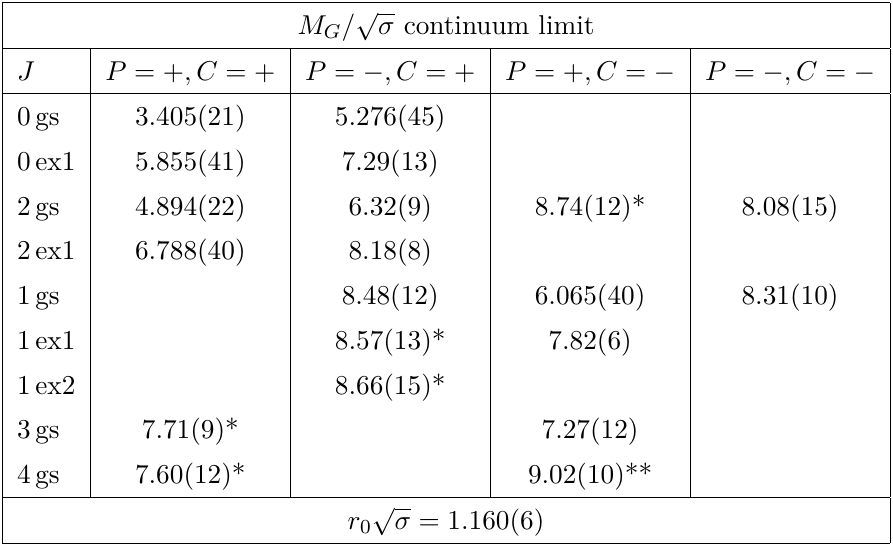
Table 17 . Continuum limit of glueball masses, in units of the string tension, for those J PC representations we can identify. Ground state denoted by gs , i ’th excited state by exi . Stars √ denote uncertainties. To change scale from σ to r 0 use value indicated.